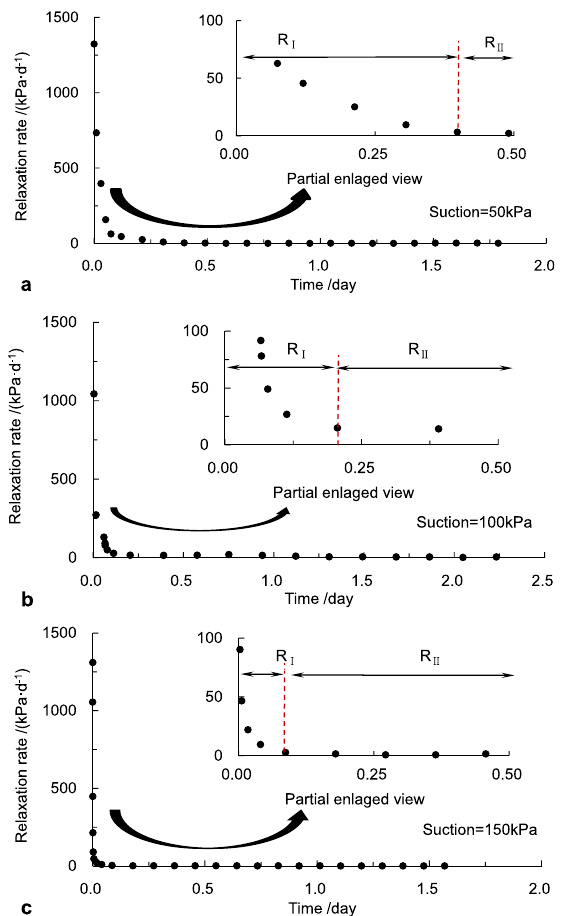
Figure 6. The characteristics of relaxation rate at the 1% strain: ( a) suction = 50 kPa, ( b) suction = 100 kPa and ( c) suction = 150 kPa.